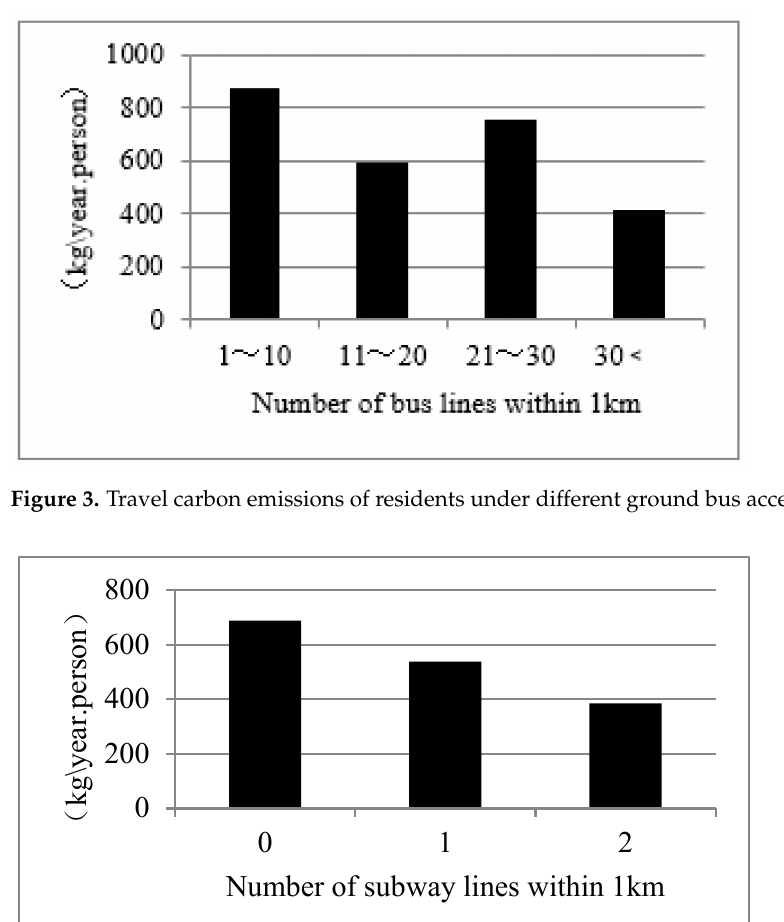
Figure 2. Travel carbon emissions of residents with different distances from community to CBD.